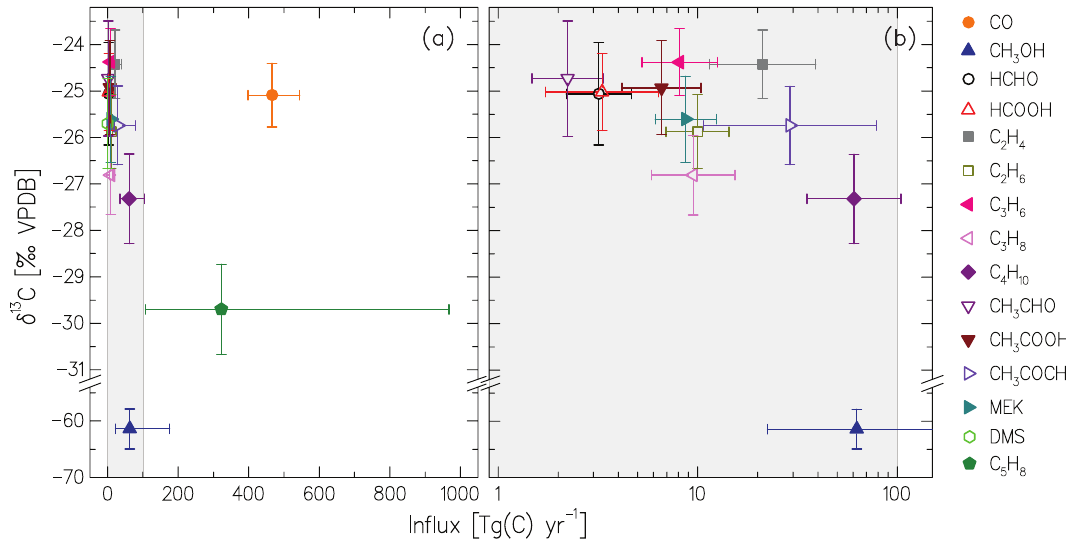
Figure 8. (a) Overall annual surface emission isotopic compositions of the carbonaceous compounds. (b) Expanded shaded area in the left panel for the NMHCs/VOCs. The error bars refer to the uncertainty factors from Table 5 and are discussed in Sect.